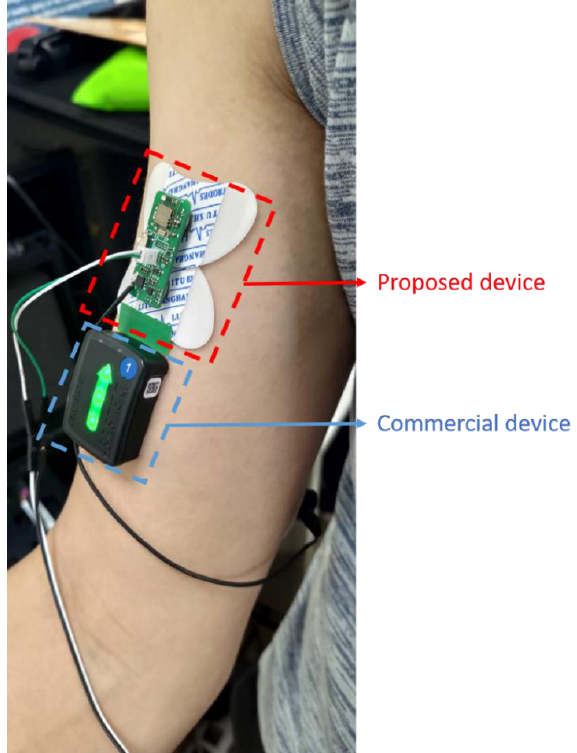
Figure 14. The electrode placement of the two systems.